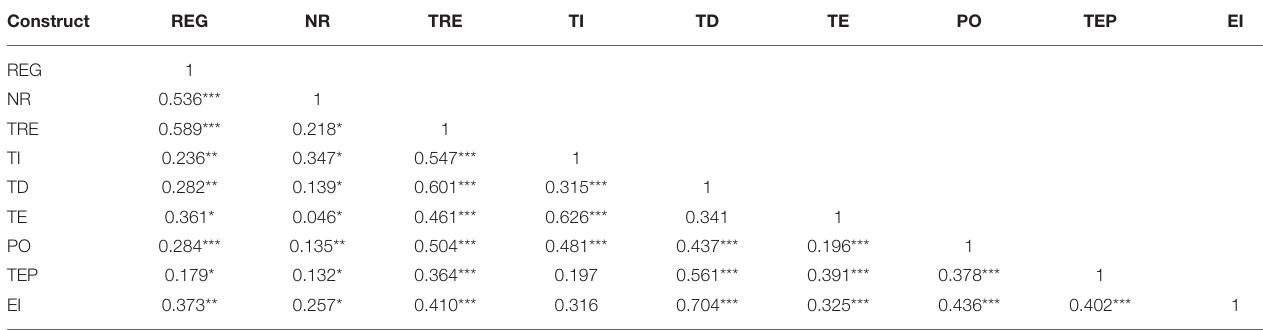
TABLE 3 | Correlation between latent variables of the propounded conceptual pathway model.